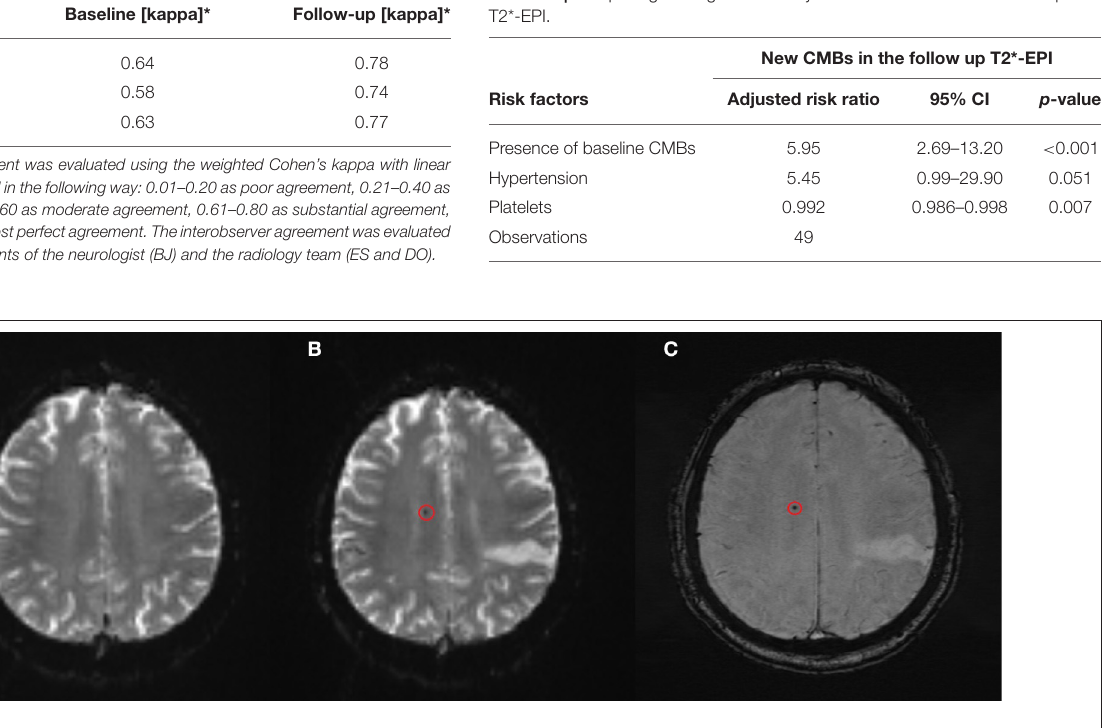
FIGURE 1 | New CMB found on the follow-up MRI on day 7–9 after rtPA treatment (A) baseline T2*-weighted EPI-GRE sequence, (B) follow-up T2*-weighted EPI-GRE, (C) susceptibility-weighted imaging confirmatory slice.